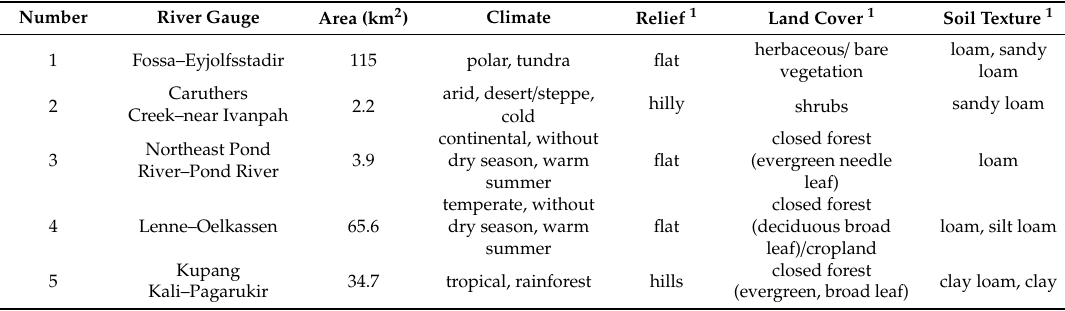
Figure 4. Outlook on the chosen catchments (WGS-84 Pseudo-Mercator projection) with Koeppen–Geiger Table 2. Table 2. Characteristics of chosen